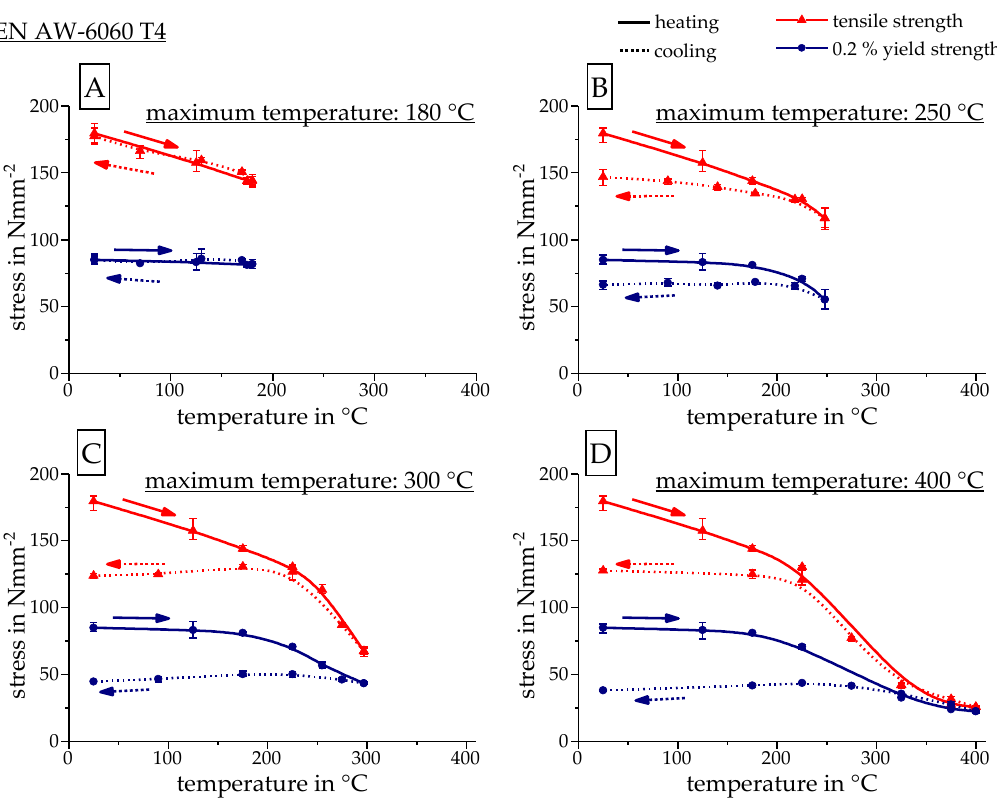
Figure 5. Mechanical properties (0.2% yield and tensile strength) during various short-term heat treatments. Experiments described in